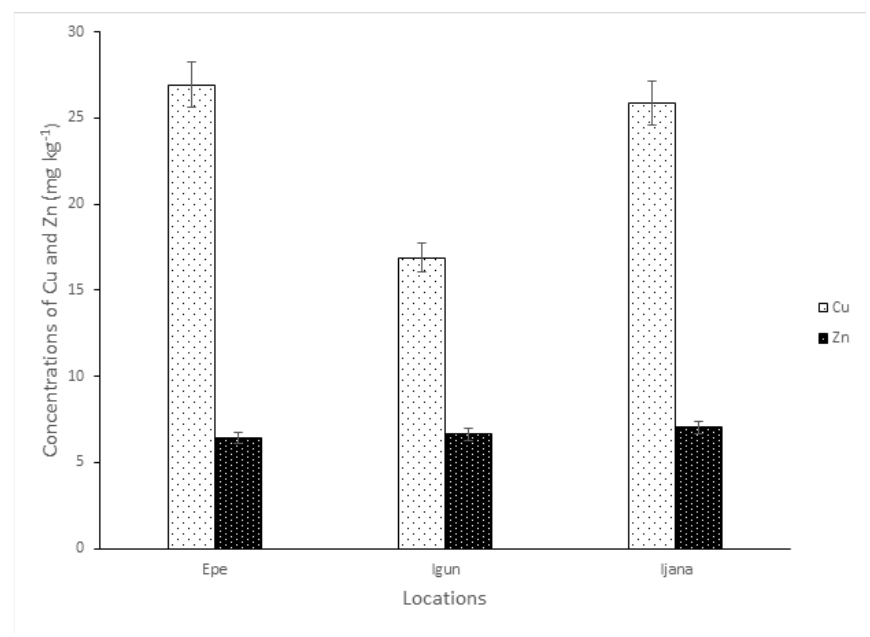
Figure 4: Concentrations of Cu & Zn in tomato at Epe, Igun and Ijana sites